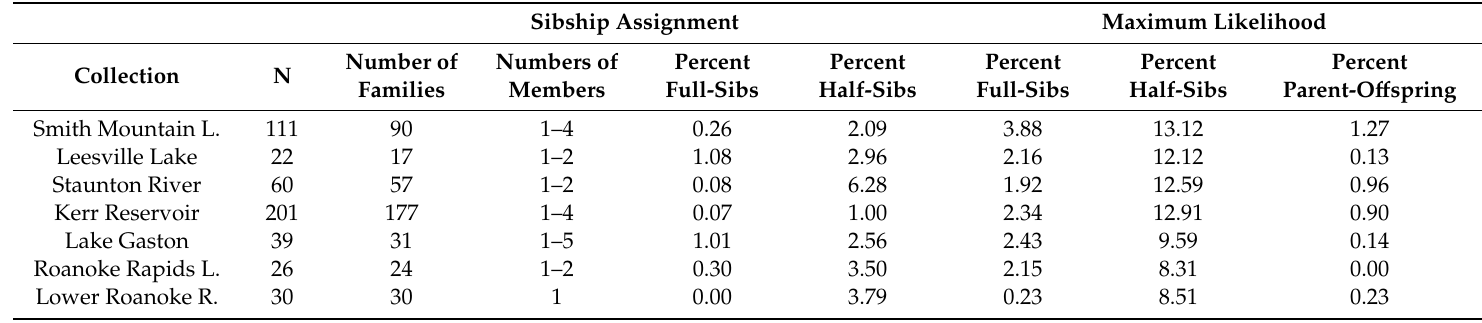
Table 9. Analysis of relatedness for Roanoke basin collections using sibship assignment [47] and maximum likelihood [48] methods. The criterion of likelihood for assignment was set at L >